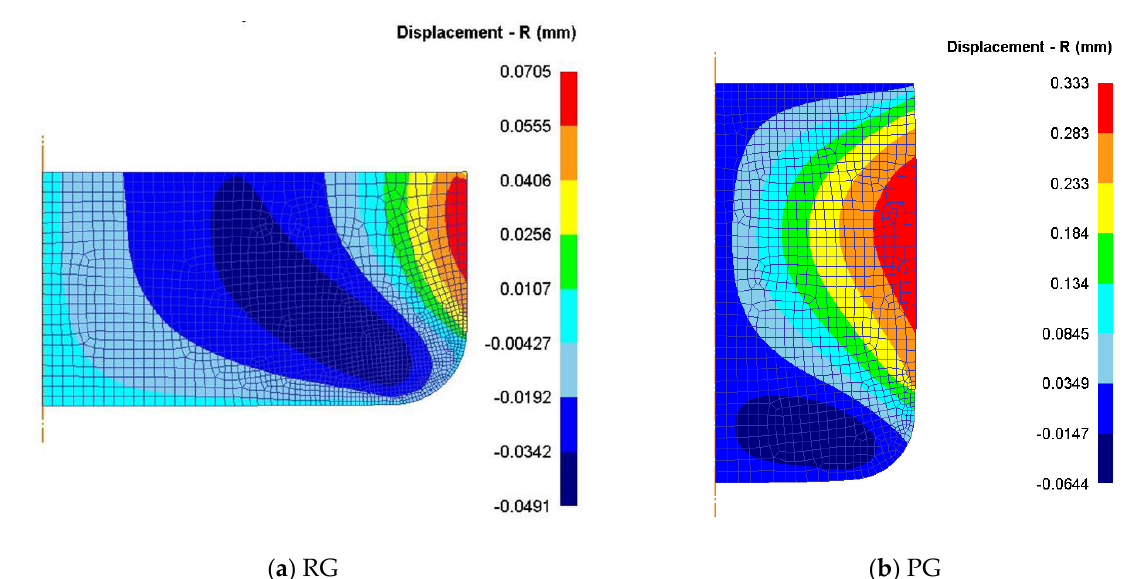
Figure 13. Radial displacement of simulated punches at the end of the deep drawing process.